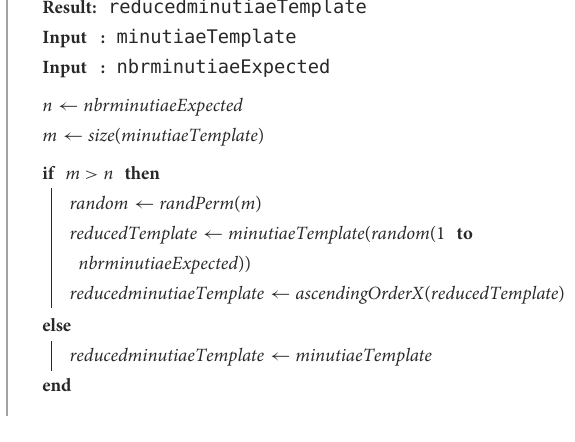
Algorithm 2. Random truncation method.